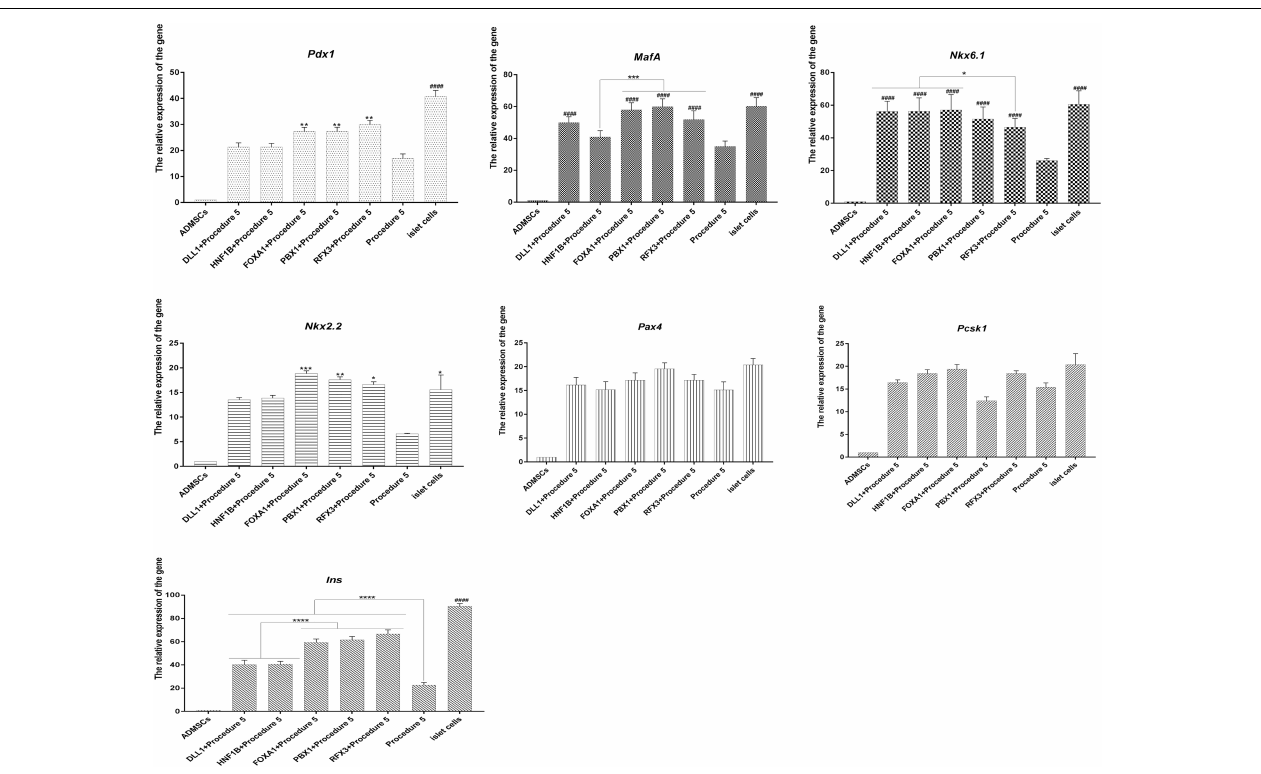
FIGURE 7 | RT-qPCR analysis. The overexpression of Foxa1 , Hnf1b , Dll1 , Pbx1 , Rfx3 can significantly stimulate high expression of islet cascade regulatory genes, with higher expression level than procedure 5. After Foxa1 , Pbx1 , and Rfx3 were overexpressed, the expression of Pdx1 , Ins , and Nkx2.2 was significantly higher than that of the unexpressed group and Hnf1b and Dll1 overexpressed groups. There was no significant difference in the expression of Pax4 and Pcsk1 (#### p < 0.0001; **** p < 0.0001; *** p < 0.001; ** p < 0.01; * p <